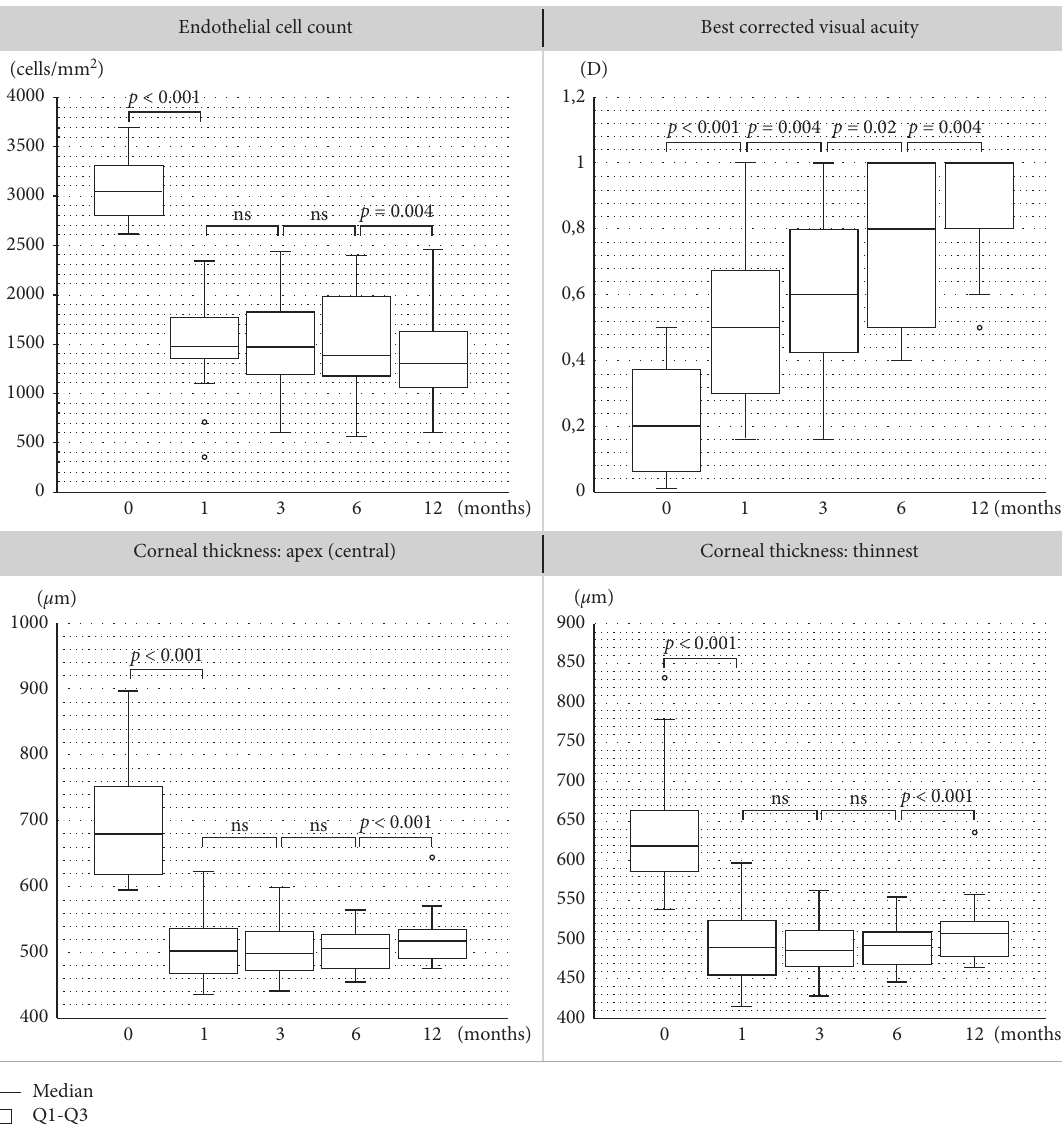
Figure 1: Boxplots showing (a) endothelial cell count (ECC), (b) best corrected visual acuity (BCVA), and corneal thickness ((c) apex- central and (d) thinnest) at baseline and at the 1st, 3rd, 6th, and 12th month after DMEK surgery. ns � not